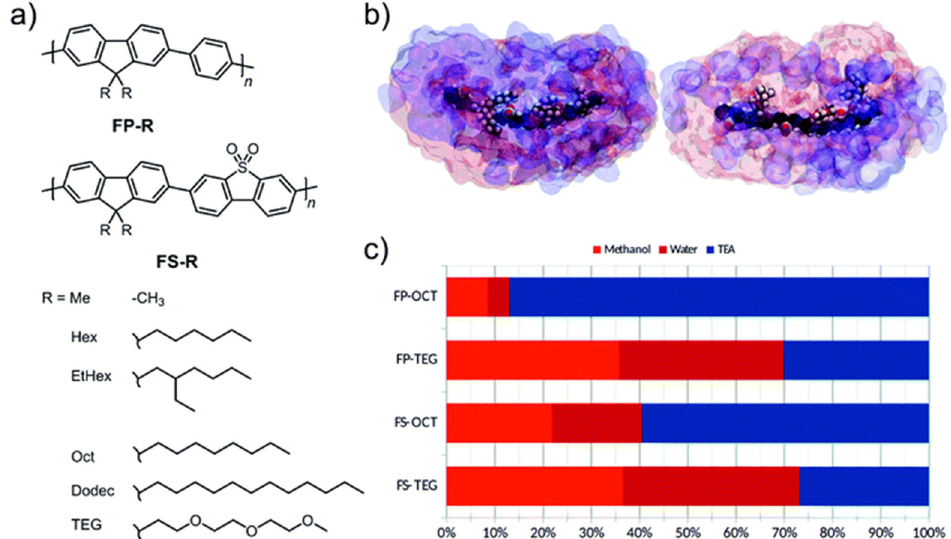
Figure 11. ( a ) Structures of the fluorene co-phenylene (FP-R) and fluorene- co -dibenzo[ b , d ]thiophene sulfone (FS-R) polymers; ( b ) Molecular dynamics simulations of FS-Oct and FS-TEG in 1 : 1 : 1 wa- ter/methanol/TEA. TEA is shown in blue, and the water/methanol phase is shown in pink; ( c ) Bar chart showing fraction of volume within a 2 nm radius of the oligomer that is occupied by each component in the liquid medium: methanol (orange), water (red) and TEA (blue) [Figure adapted from ref. [95] under CC-BY 3.0 International License].